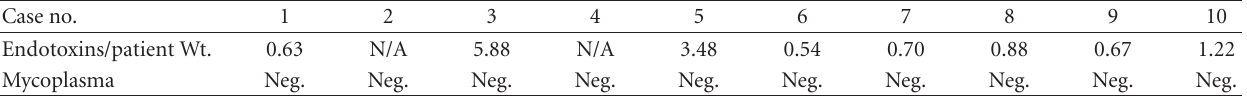
Table 3: Endotoxins (EIU)/patient body Wt. (Kg), mycoplasma